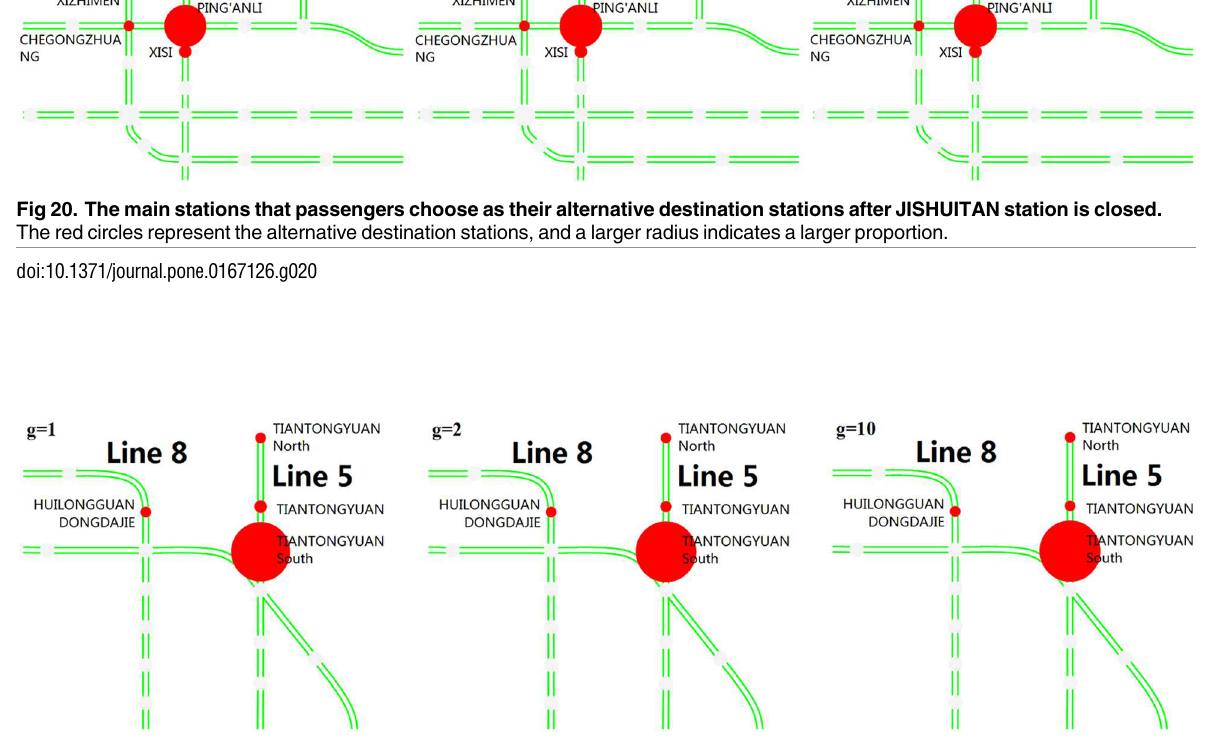
Fig 21. The main stations that passengers choose as their alternative destination stations after TIANTONGYUAN station is closed. The red circles representthe alternativedestination stations, and a larger radius indicatesa larger proportion.